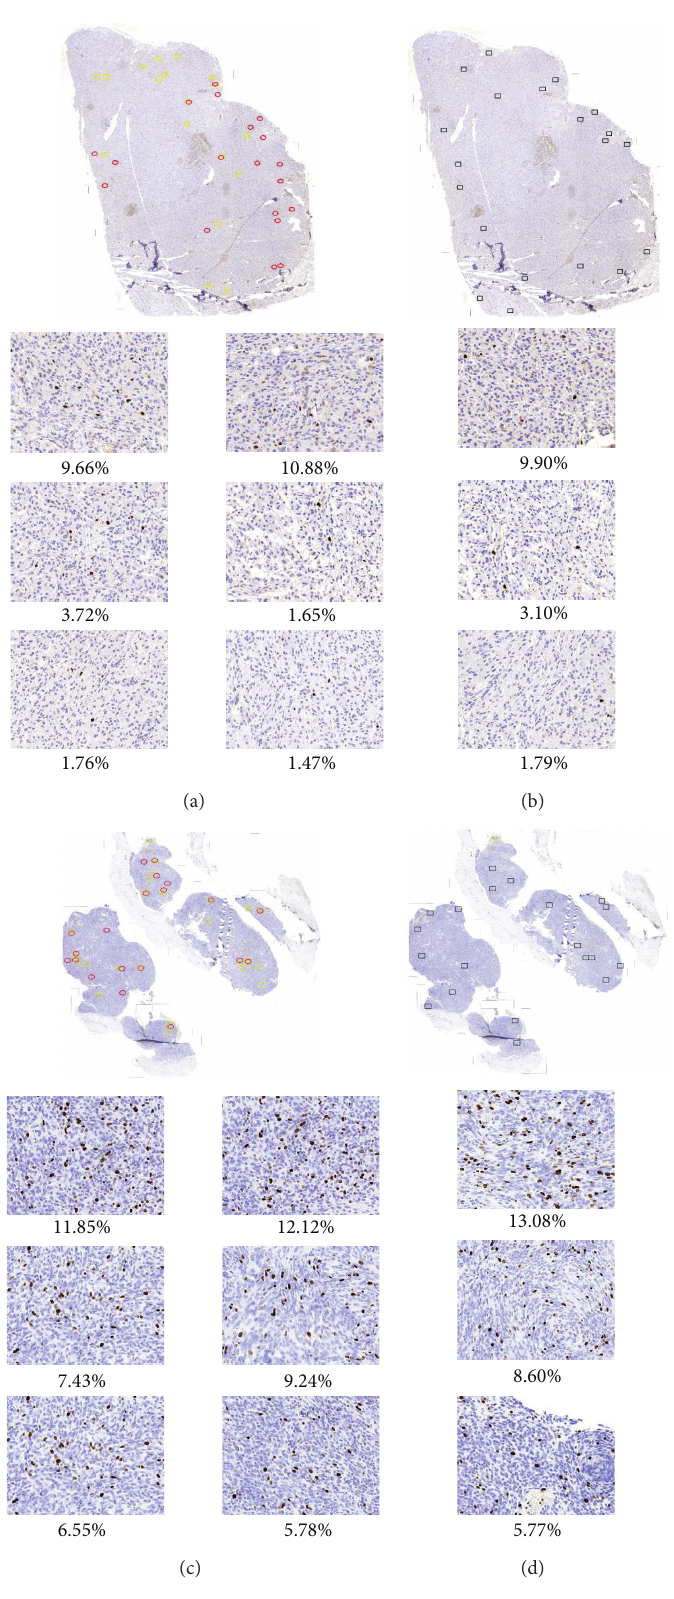
Figure 4: Two WSIs with an area of quantification inside a hot spot marked by two experts ((a) and (c): red and yellow rectangles) and chosen by the proposed automatic method ((b) and (d): black rectangles) with examples of 3 areas of quantification for each method and for both WSIs with large and small variation in Ki-67 index value calculated as percentage of immunopositive nuclei to the whole number of nuclei in presented